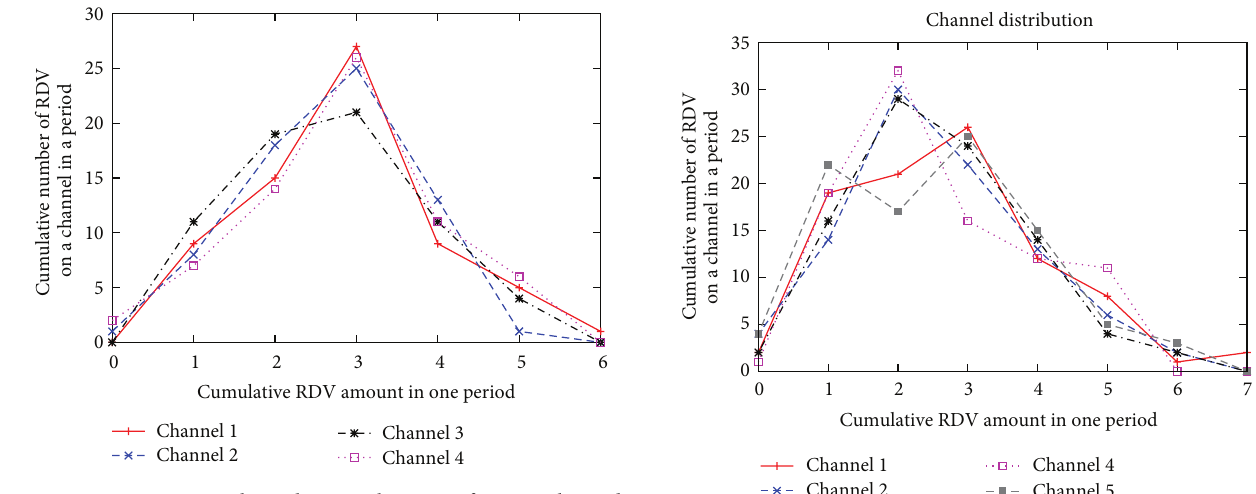
Figure 11: Asymmetric channel set: combination of maps with 4 and 6 channels.